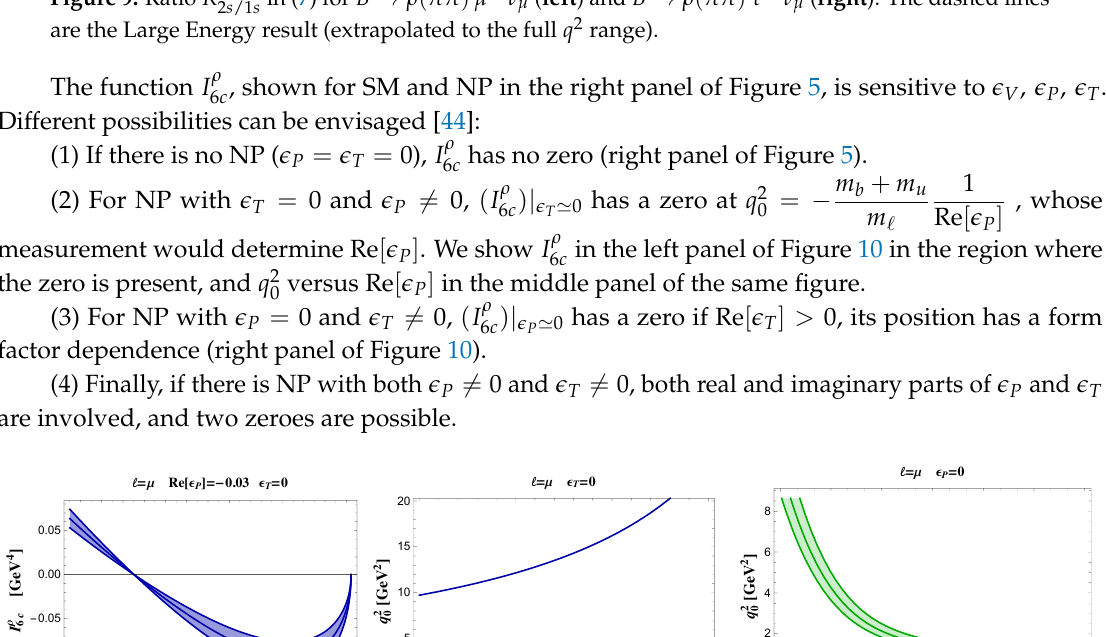
varying Re ( (cid:101) P ) with 0